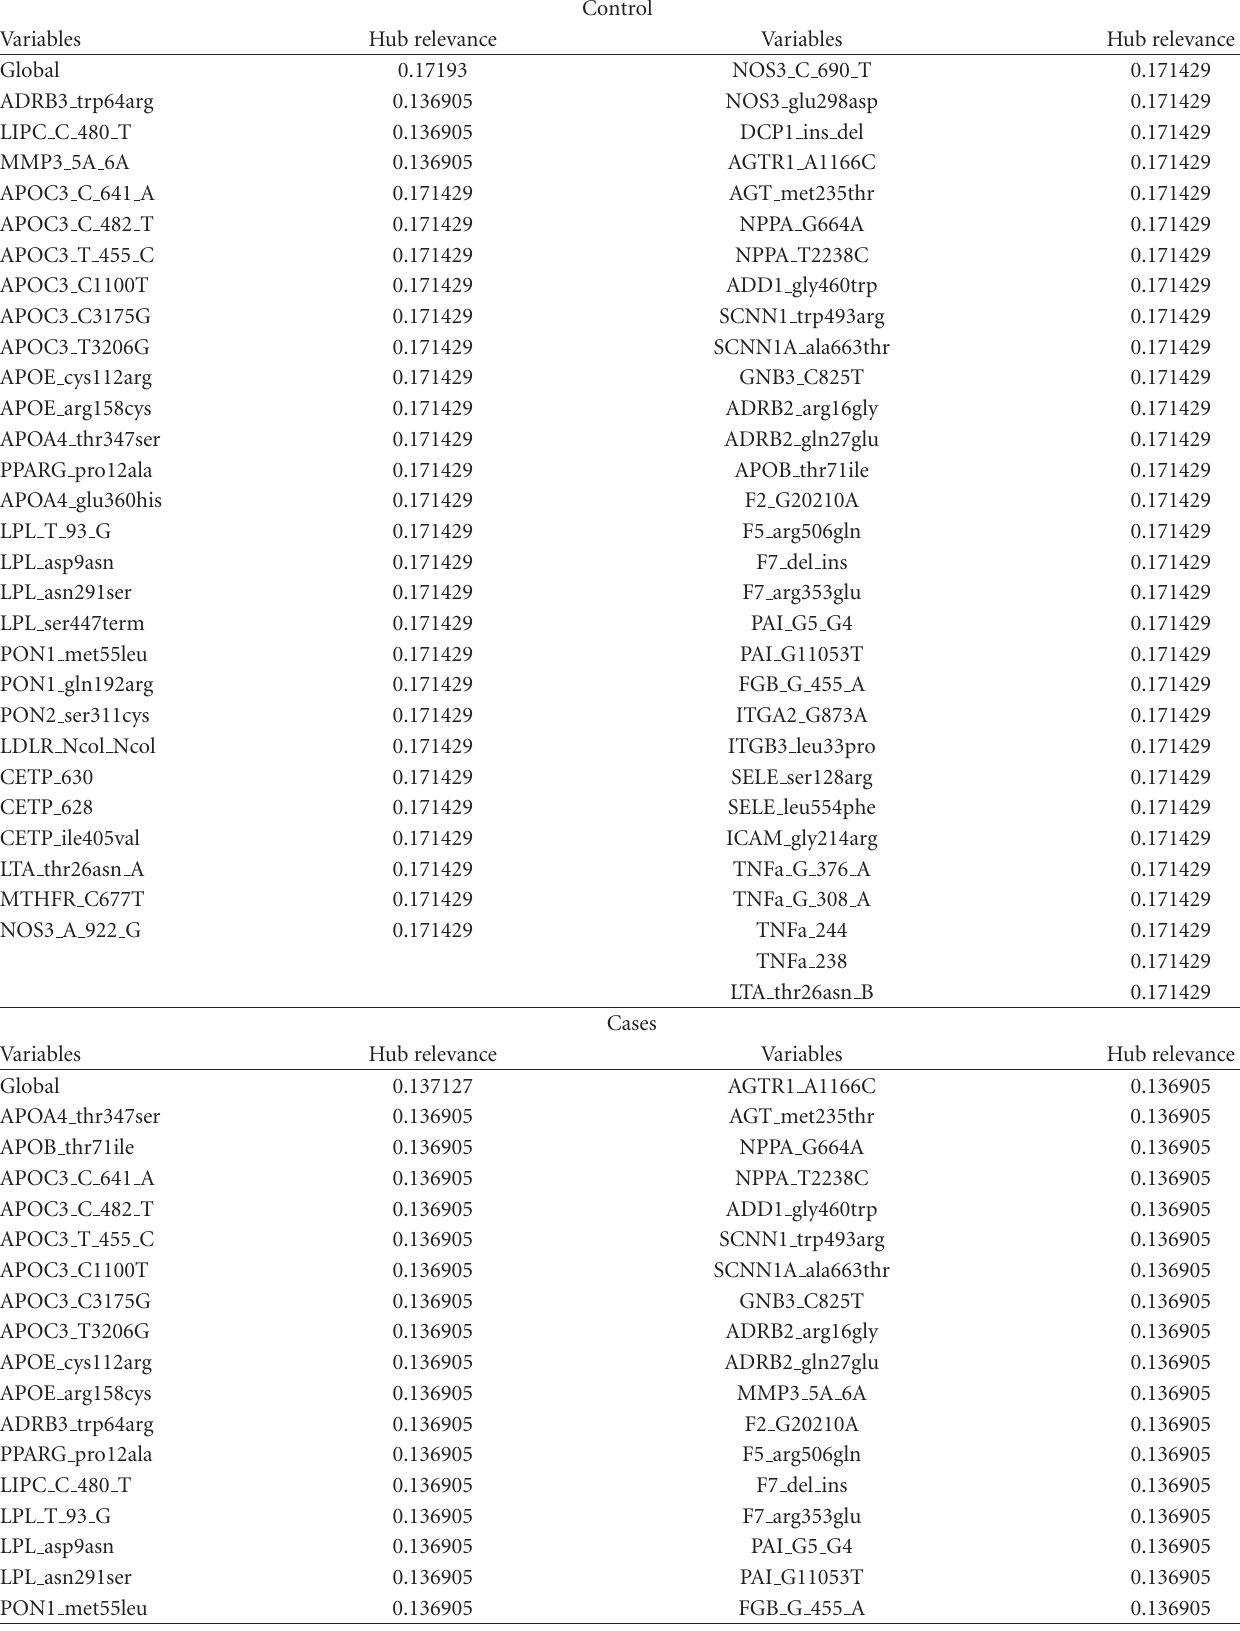
Table 1: The Delta H function with the relative hubness into the Controls and Cases